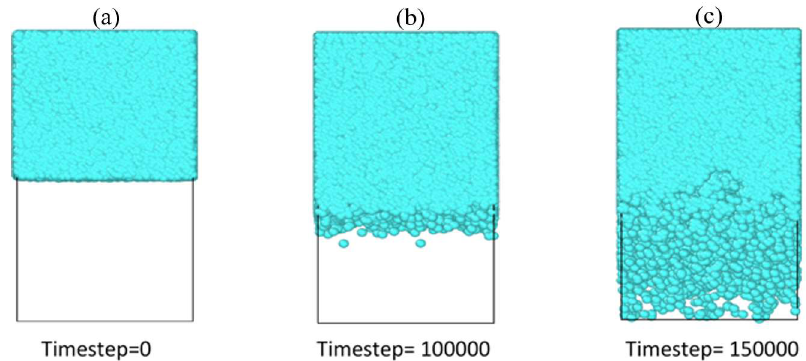
Figure 4. Evolution of the water–polyelectrolyte membranes (PEM) interface for Aciplex ( a ) At time step = 0, all water is present in the top half of the box. The bottom half of the box is the membrane, which has not been shown here to clearly see the water interface. ( b ) At time step = 100,000, water has penetrated some distance into the membrane, with some isolated clusters formed. ( c ) Water has penetrated almost completely into the membrane, with a more homogeneous distribution of the water clusters.